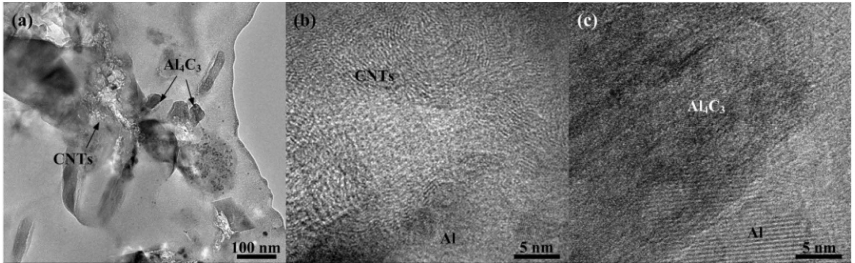
Figure 10. TEM images of the sintered CNT/Al (with powder size of 5 µ m) composites that were ball milled for 24 h: ( a ) shows dispersion of the CNTs and the formation of Al 4 C 3 ; ( b ) HRTEM image of CNTs in the composites; ( c ) HRTEM image of the Al 4 C 3 .